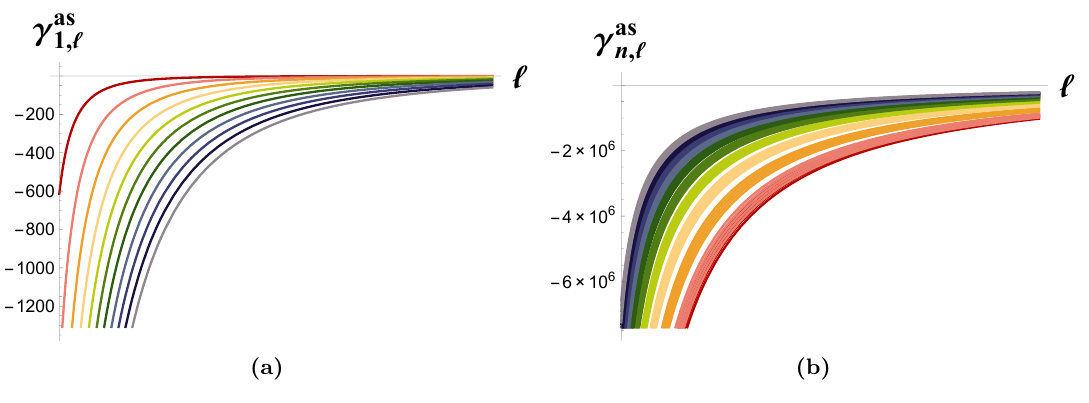
Figure 4. The same setup as in (cid:12)gure 3, but now for (cid:28) = 4 ; s = 2 exchange, (cid:13) as cases, the result is negative and convex as a function of ‘ . Notice that in this case, (cid:13) n;‘ as a function of (cid:1) in the right